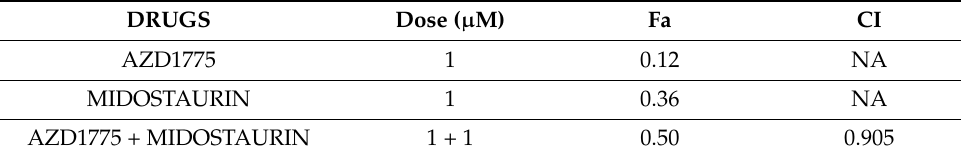
Table 2. HMC-1.2. Effects of WEE1 or KIT inhibition alone or in combination. Data obtained by cytofluorimetric evaluation of apoptotic cell death were analyzed by using a dedicated software (Compusyn) and the combination index (CI) was calculated. Fa is the fraction of cells affected by drugs